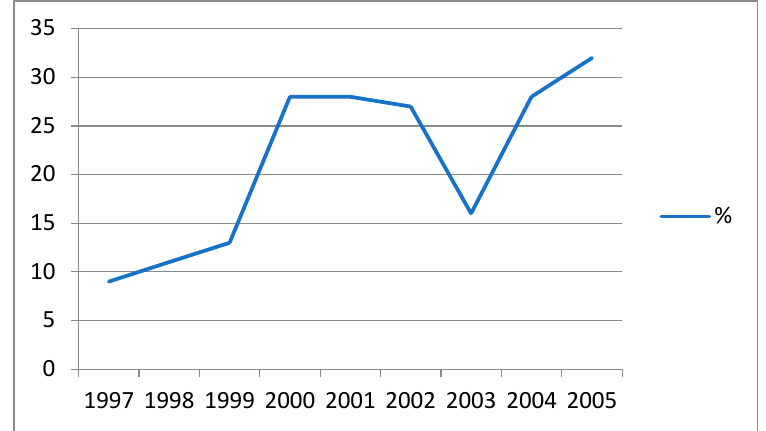
Figure 5. Prevalence of filariasis in dogs, Rostov-on-Don region, 1997–2005. It was also observed that the infection rate in female dogs was 2.5 times higher than that in male dogs [32].